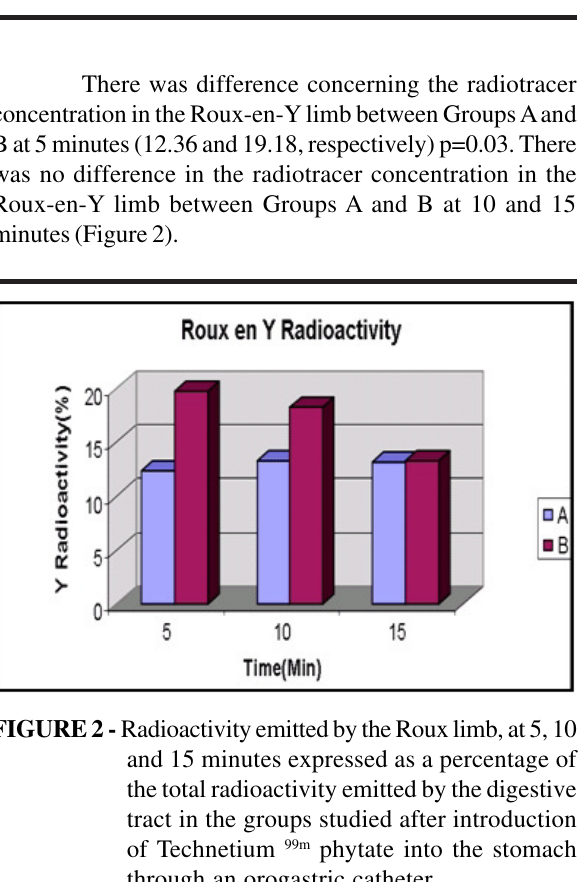
FIGURE 1- Radioactivity emitted by the Stomach at 5, 10 and 15 minutes expressed as a percentage of the total radioactivity emitted by the digestive tract in the groups studied after introduction of Technetium 99m phytate into the stomach through an orogastric catheter.